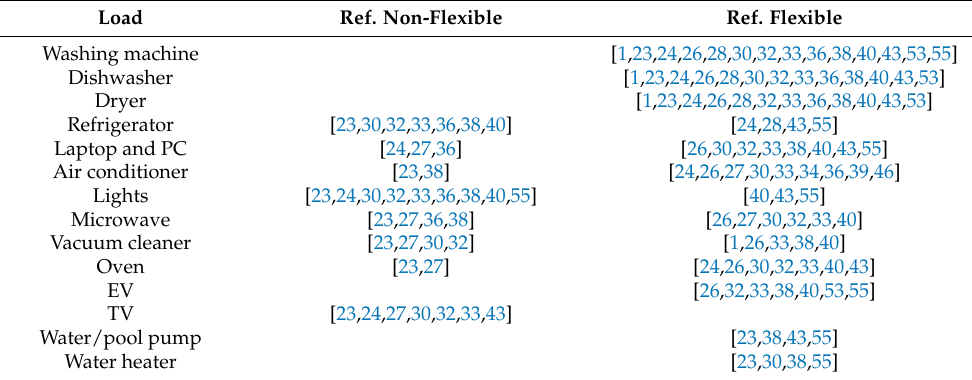
Table 3. Flexible and non-flexible residential loads analyzed in the